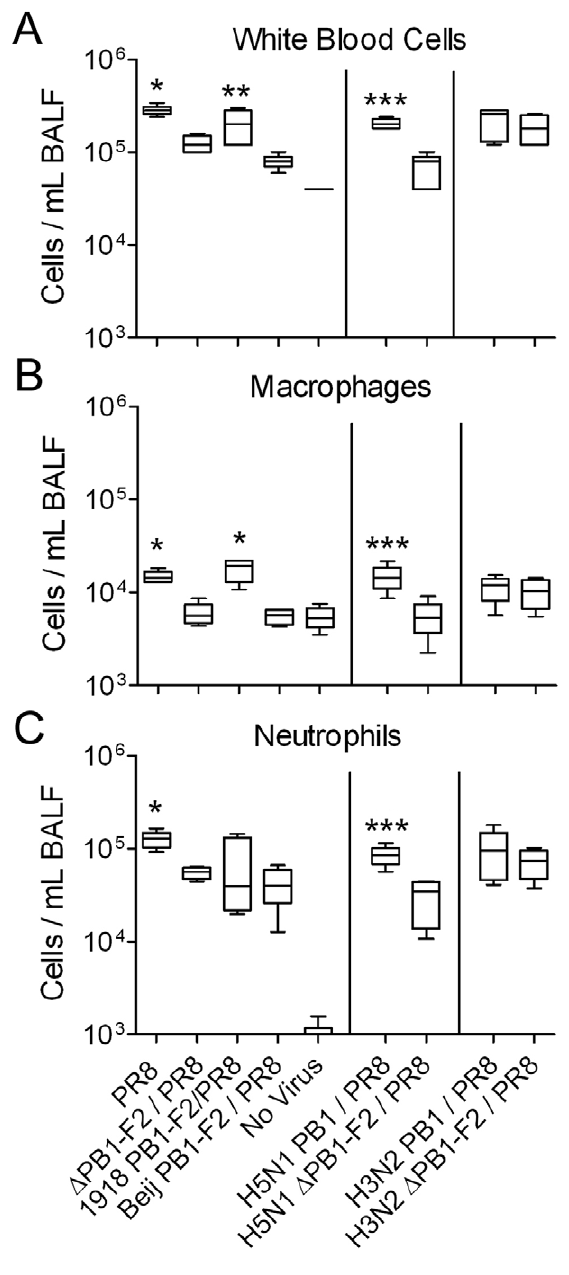
Figure 5. PB1-F2 enhances viral-mediated lung inflammation. Groups of mice were infected with a panel of viruses (see methods for definitions) and euthanized 72 hours post-infection. BAL fluid from the animals was assayed by flow-cytometry [10] for the mean number of A) white blood cells, B) macrophages, and C) neutrophils compared to uninfected mice or mice infected with a virus lacking the ability to express PB1-F2. An asterisk (*) indicates a significant difference compared to animals infected with the D PB1-F2/PR8 or Beij PB1-F2/ PR8 viruses, and uninfected control animals by ANOVA (p , 0.05). A double asterisk (**) indicates a significant difference compared to animals infected with the Beij PB1-F2/PR8 virus and uninfected control animals. A triple asterisk (***) indicates a significant difference compared to animals infected with the H5N1 D PB1-F2/PR8 virus and uninfected control animals. Error bars indicate the standard deviation from the mean.